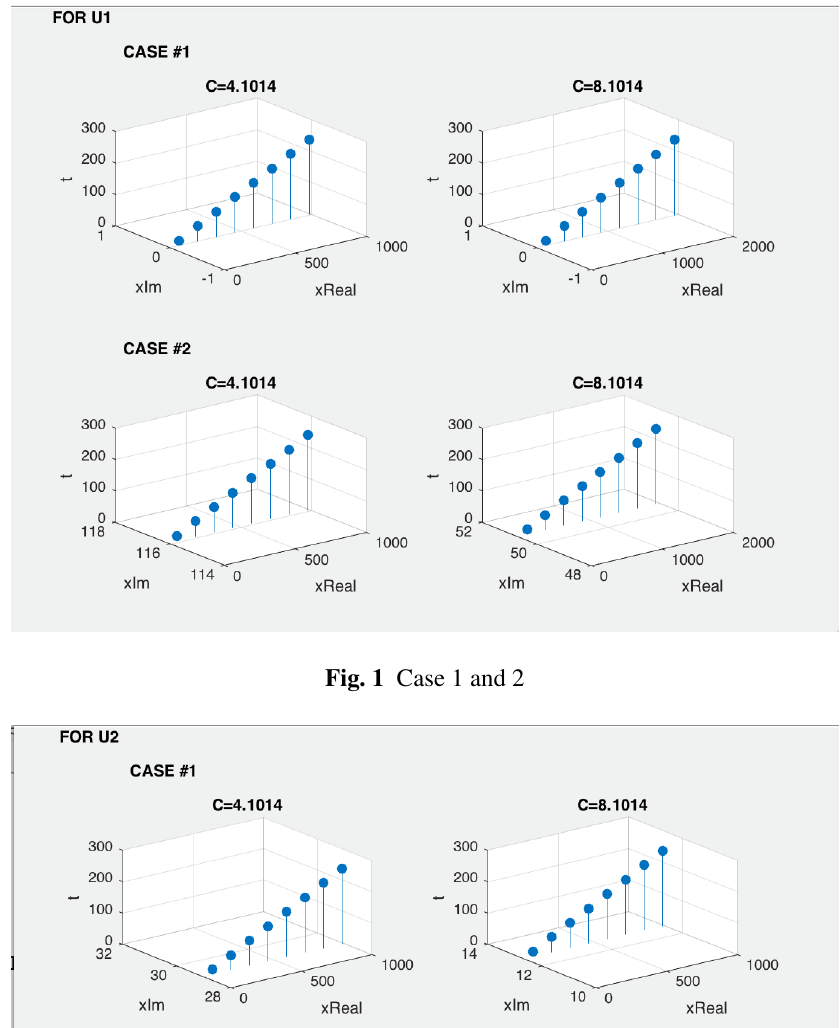
Fig. 2 Case 1 and